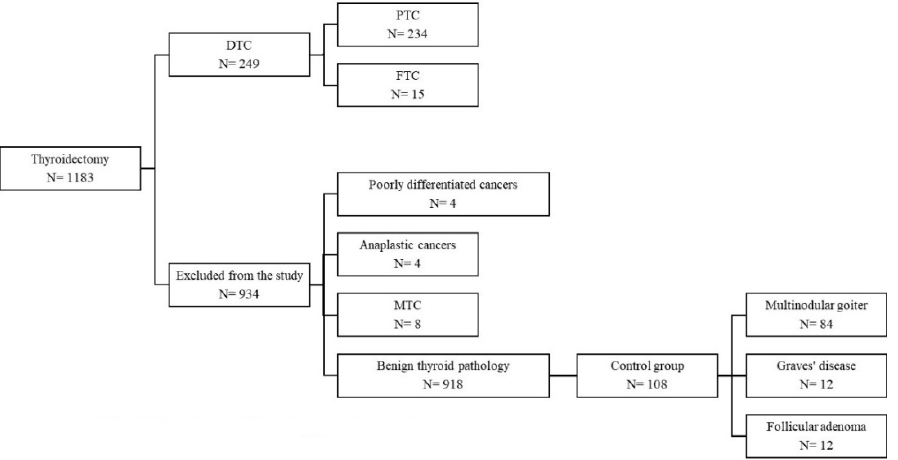
Figure 1. Flow diagram of the patient selection